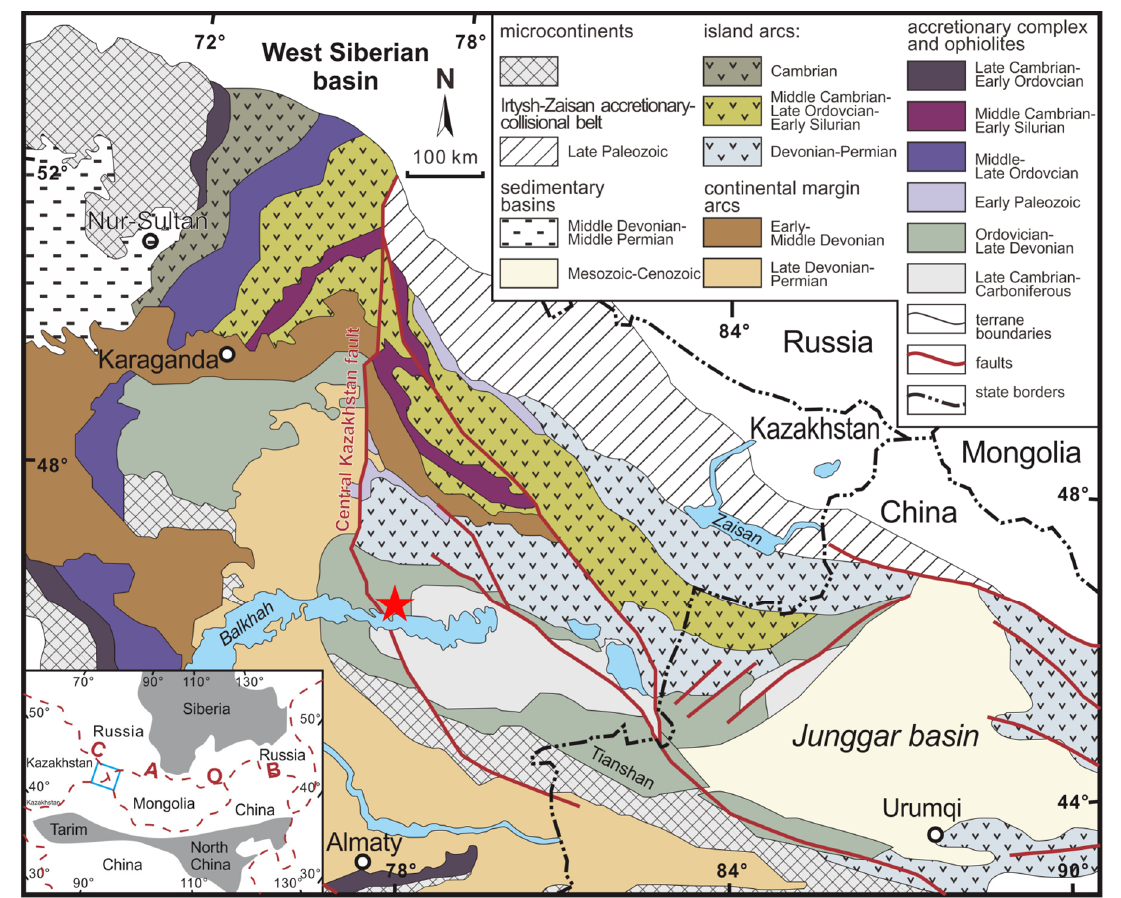
Figure 1. Simplified tectonic scheme of the western Central Asian Orogenic Belt and location of the Itmurundy belt shown as red star (Adapted with permission from Refs. [31,40], Copyright (2023), with permission from Elsevier).